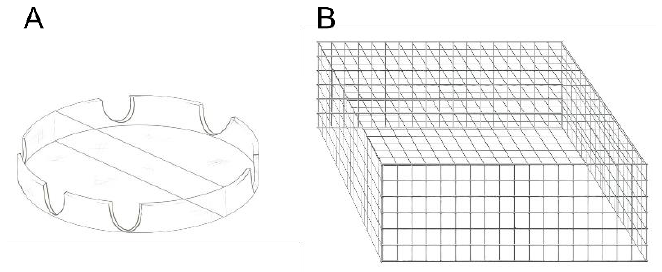
Figure 2. Diagrams of ( A ) the I-plate Petri dish used as the seed depot modified with entrances; and ( B ) the depot cage constructed from wire to protect seeds from larger granivores. ( B ) the depot cage constructed from wire to protect seeds from larger